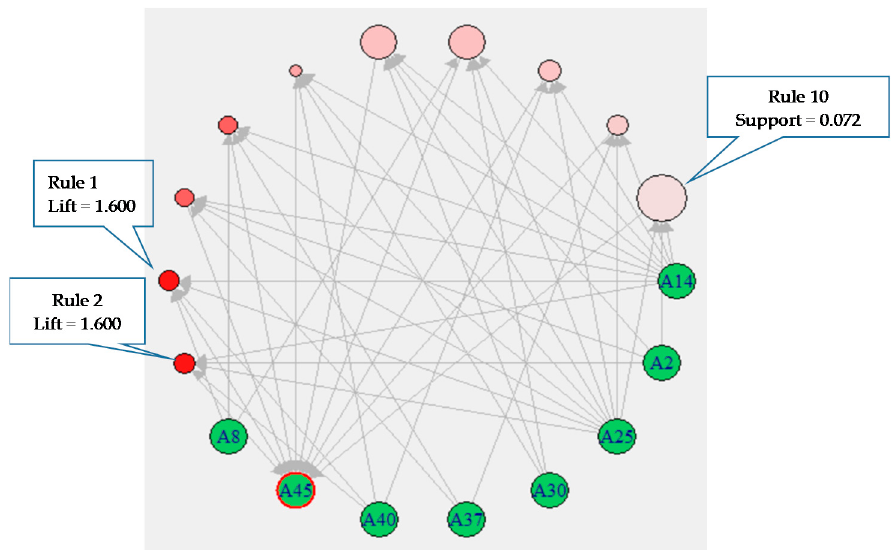
Figure 4. Graph-based visualization, with items for the top 10 high-confidence rules. (Size: support (0.05–0.072); Color: lift (1.582–1.600)).